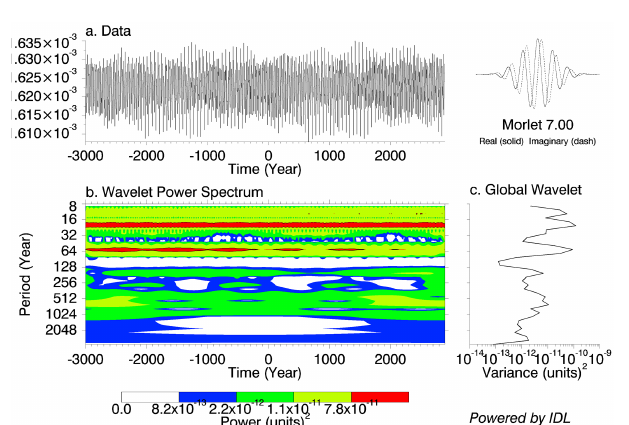
Figure B9. (a) Lateral force [arbitrary units]. (b) The wavelet power spectrum. The contour levels are chosen so that 75, 50, 25, and 5% of the wavelet power is above each level, respectively. The cross-hatched region is the cone of influence, where zero padding has reduced the variance. (c) The global wavelet power spectrum (black line). The dashed line is the significance for the global wavelet spectrum, assuming the same significance level and back- ground spectrum as in (b) . Reference: Torrence and Compo